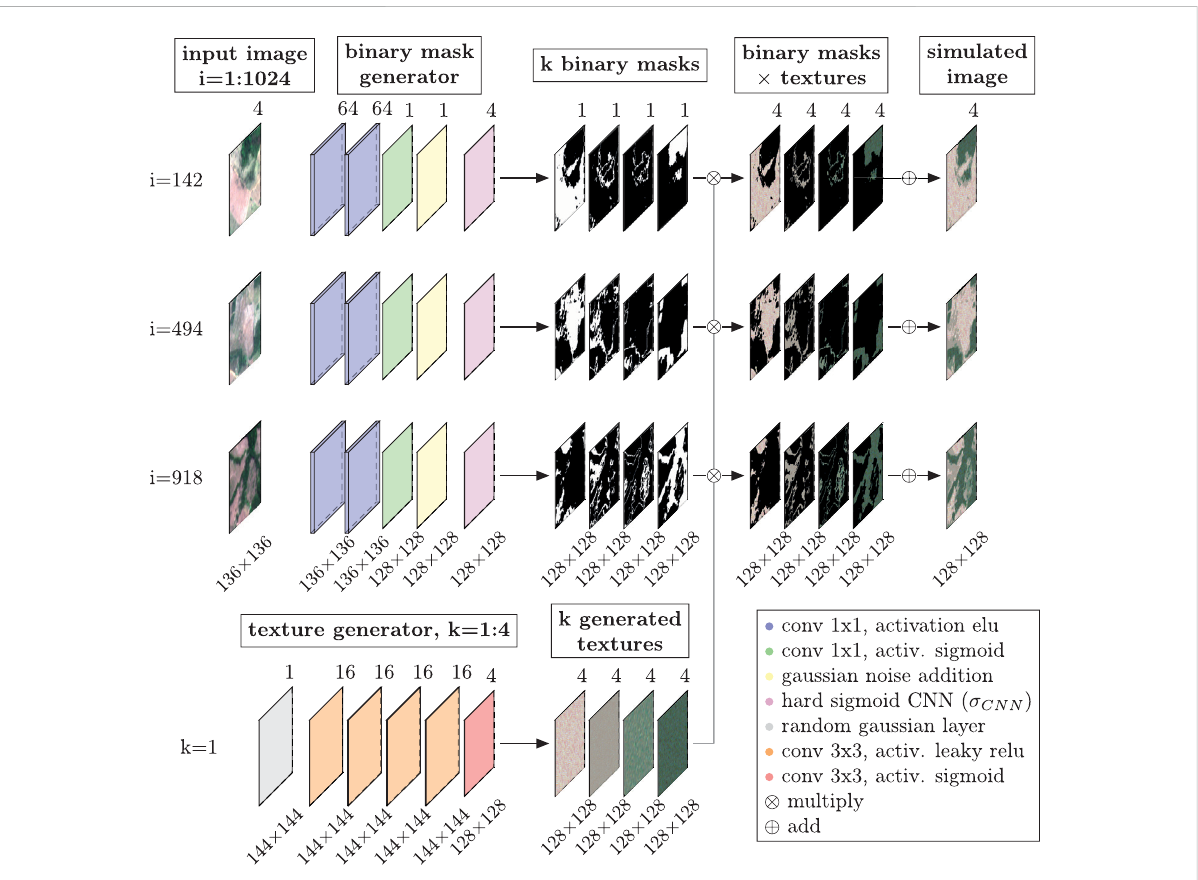
FIGURE 4 K-textures Model Architecture and example for k = 4. The Planet image (4,096 × 4,096 pixels) is inputted to the k-textures algorithm in square patches of 136 × 136 pixels with 8 pixels of overlap (1,024 patches). k binary masks are generated for each patch. One texture is generated for each k classes with thetexture generator, to produce k textures of 128 × 128 pixels. Notethat only k textures of 128 × 128 pixels are estimated for theentire Planet image ( k = 4 in the example). The k textures and the k binary masks are then multiplied and the result summed to produce a simulate image of each patch. During the training, the loss that contains theVAE and VGG16 feature extractors is computed betweenthe input and simulated